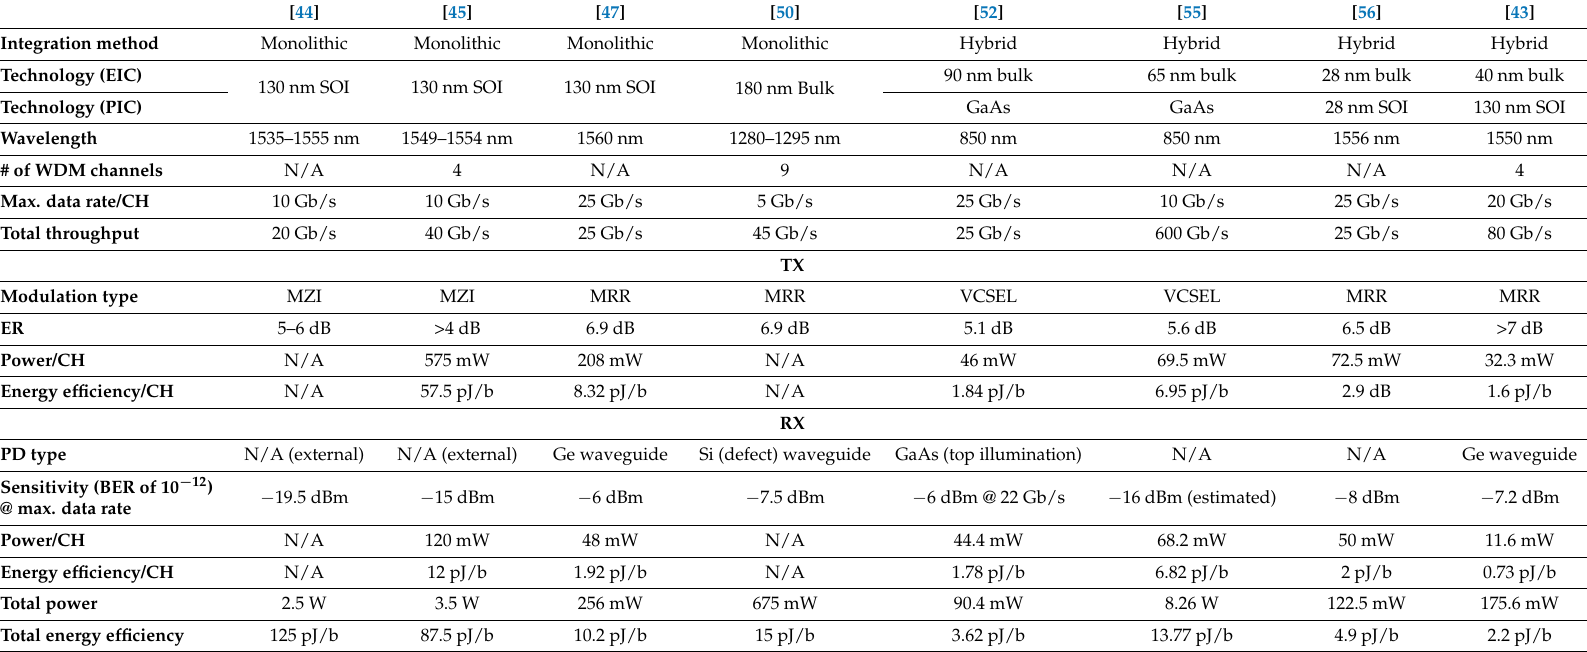
Table 1. Summary of monolithic and hybrid-integrated optical